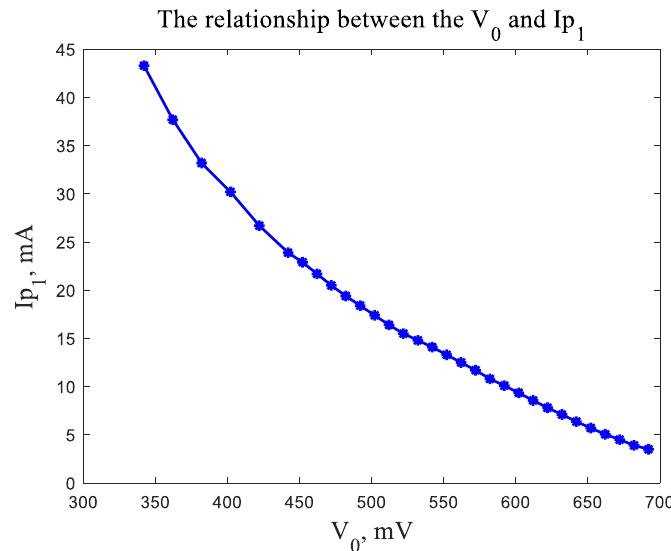
Figure 9. Revolving drum test bench.